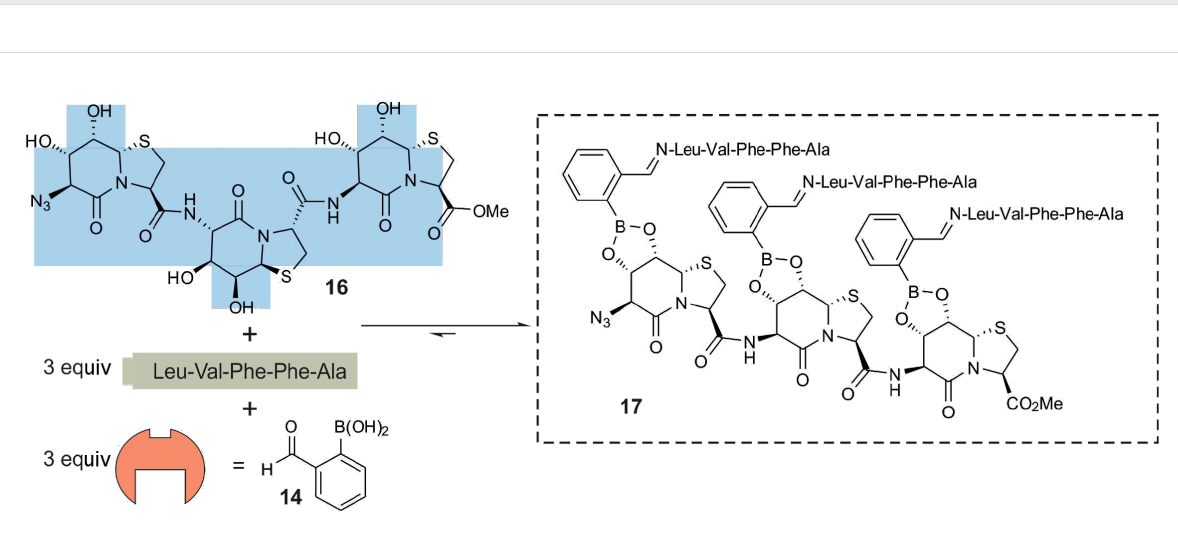
Figure 9: The trimeric template 16 together with 3 equivalents of pentapeptide LVFFA and 2-formylphenylboronic acid ( 14 ) forms trimer 17 . The equi- librium lies far on the side of the triple ester in spite of the 9 equivalents of water which are released during the conversion in DMSO- d 6 at 300